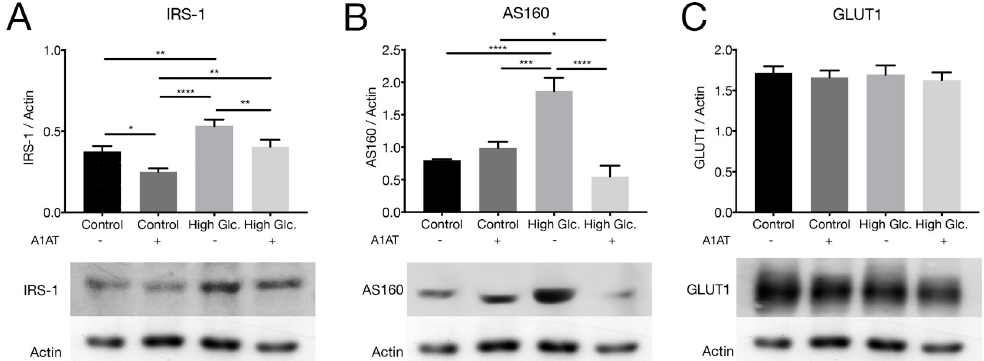
Fig 5. Insulin pathway proteins involved in glucose metabolism under high glucose and with A1AT treatment. Expression of different intermediates of insulin pathway was measured by western blot (A) IRS-1, (B) AS160 and (C) GLUT1. High glucose group expressed as ‘High Glc’. Results were expressed as protein vs. Actin expression mean ± SD. � p < 0.05, �� p < 0.01, ��� p < 0.001, ���� p < 0.0001 vs. Control. Due to the different molecular weight of IRS-1, AS160, GLUT1 and Actin, the same PVDF membranes were incubated with the different antibodies, for this reason, Actin band pattern is repeated amongst the different proteins showed.